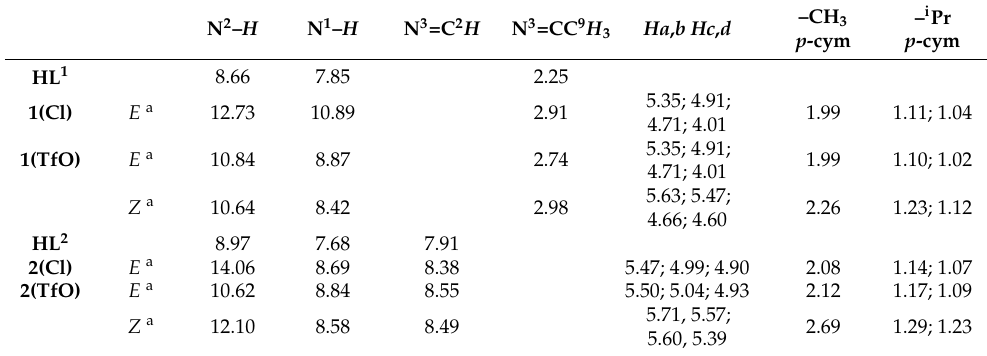
Table 1. Relevant 1 H NMR chemical shift values ( δ in ppm) for HL 1 and HL 2 and their complexes in CD 2 Cl 2 .